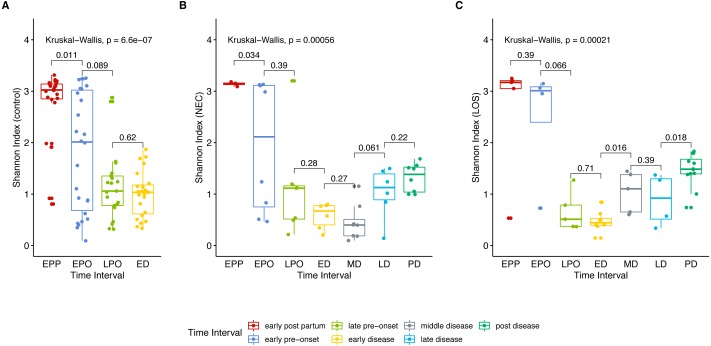
Post-partum microbiome evenness (Shannon diversity) trend in each group.Shows microbial richness trend in stools from cases and controls. (A) control group. (B) NEC group. (C) LOS group. Horizontal line shows median, box boundaries show 25th and 75th percentiles. Shannon index value of each stool is depicted as one dot. p = 0004 for NEC and p = 0.010 for LOS from early preonset to early disease (two way RM ANOVA) indicating significantly discordant trends in bacterial diversity preceding disease onset. p values between two adjacent intervals were calculated by the Mann–Whitney U test.